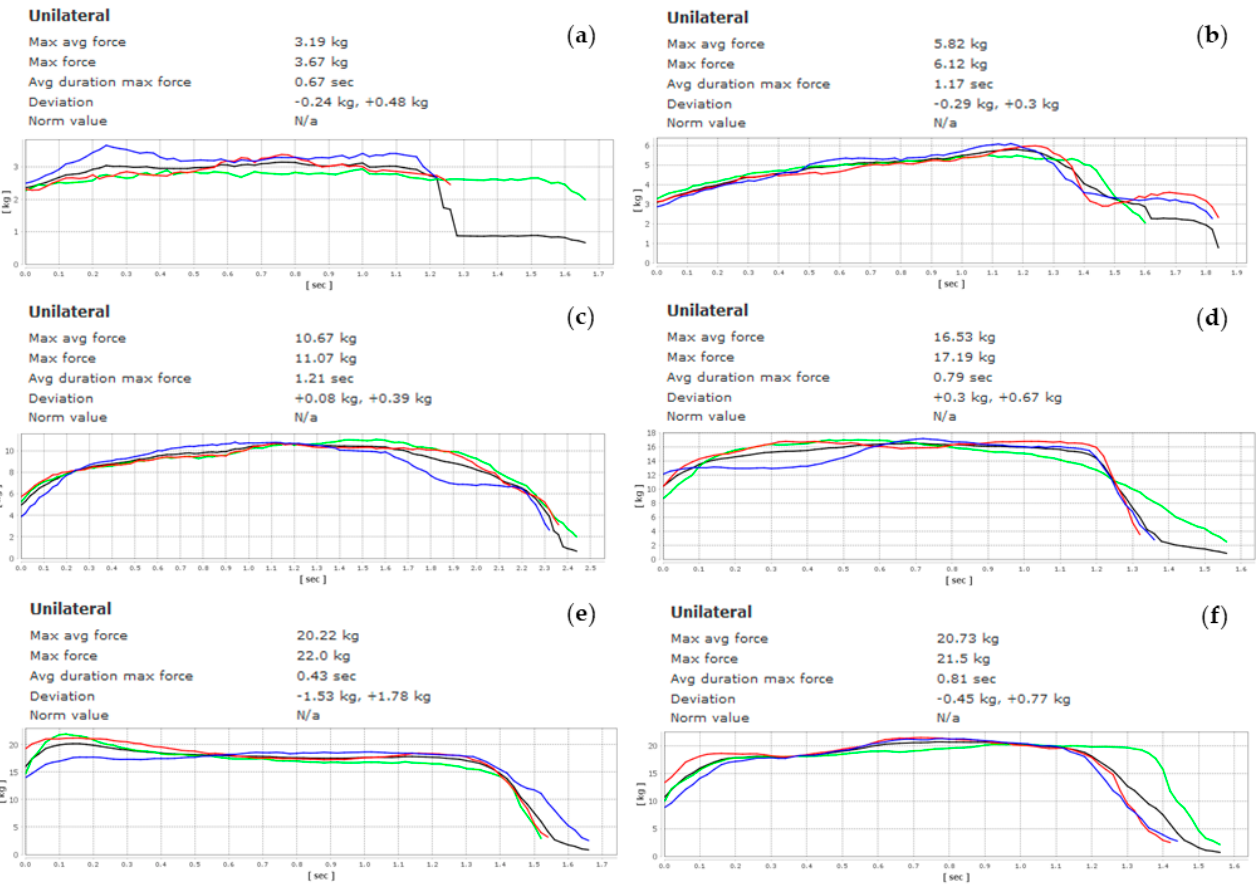
Figure 6. Dynamometer muscle force graph through the weeks: ( a ) week 1, ( b ) week 2, ( c ) week 3, ( d ) week 4, ( e ) 3 ‐ month follow ‐ up, ( f ) 6 ‐ month follow ‐ up. Table 1. Physical evaluation of pain, mobility, and force through the weeks.